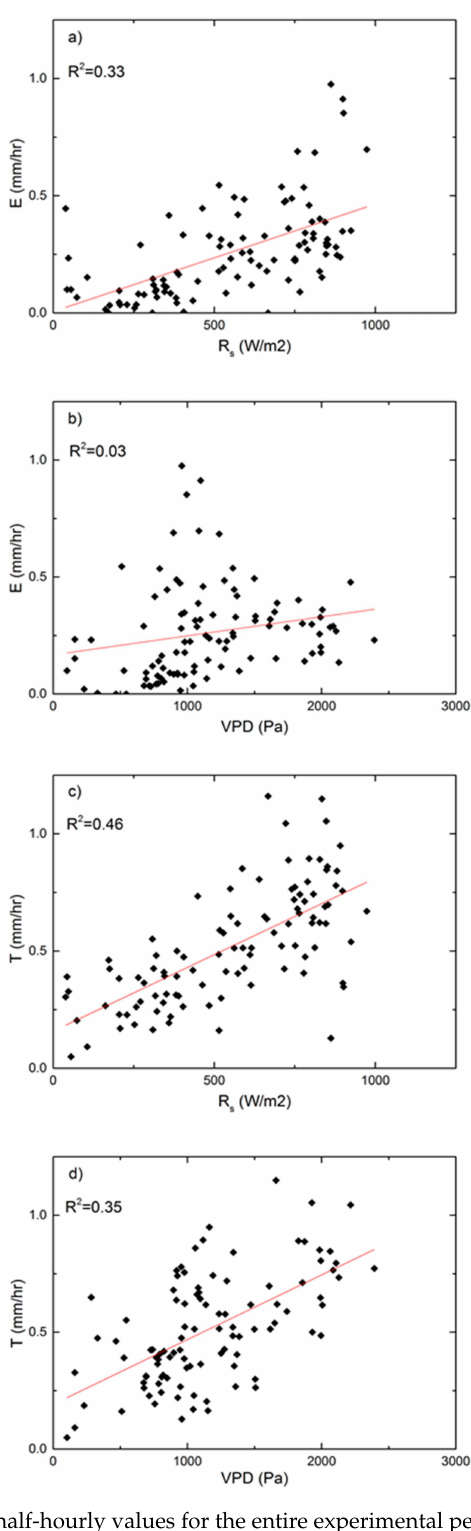
Figure 10. Scatterplots of half-hourly values for the entire experimental period. Top two figures show the comparison between soil E and ( a ) solar radiation and ( b ) vapor pressure deficit (VPD), while the bottom figures compare T with ( c ) solar radiation and ( d )